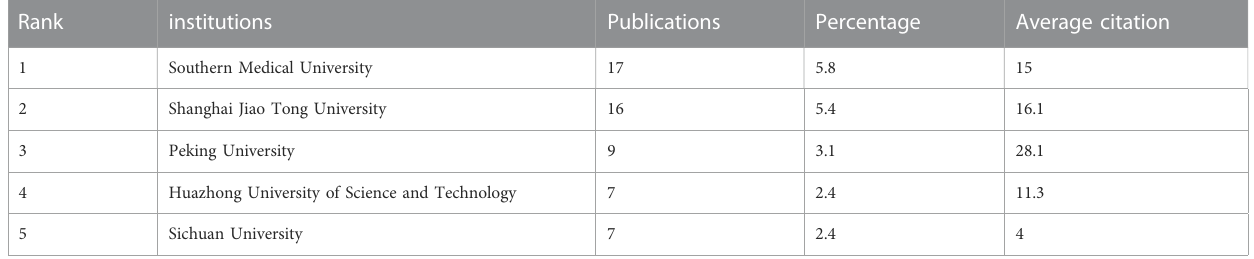
TABLE 3 The top 5 most productive institutions in the fi eld of additive manufacturing technology in pelvic surgery.